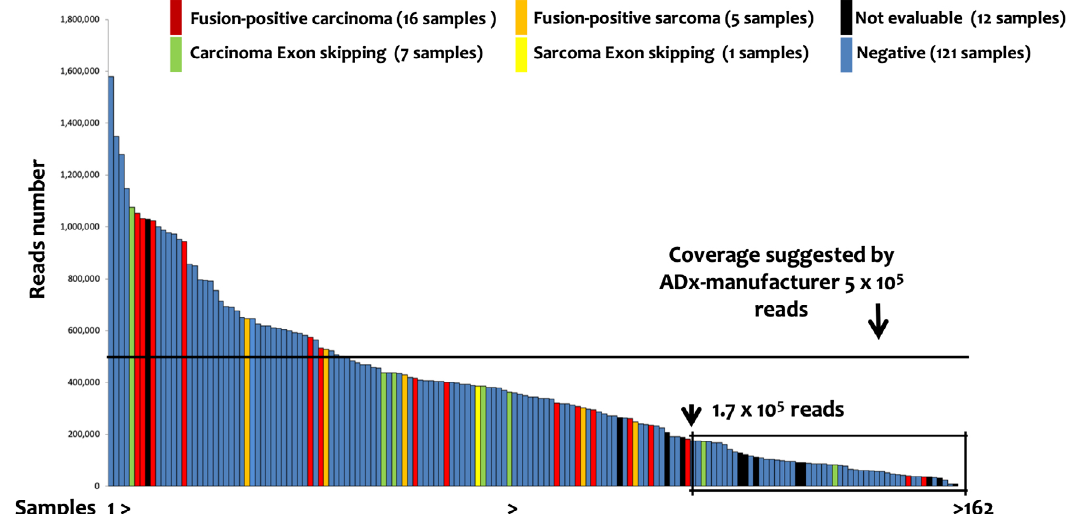
Figure 3. Lung Panel: ADx results. The 162 samples investigated by lung panel and analyzed by ADx are shown ordered on the basis of the number of the reads. The box evidenced the samples below 1.75 × 10 5 reads, identified by a recursive contingency analysis (exact Fisher t -test) as a threshold below which the results cannot be considered reliable